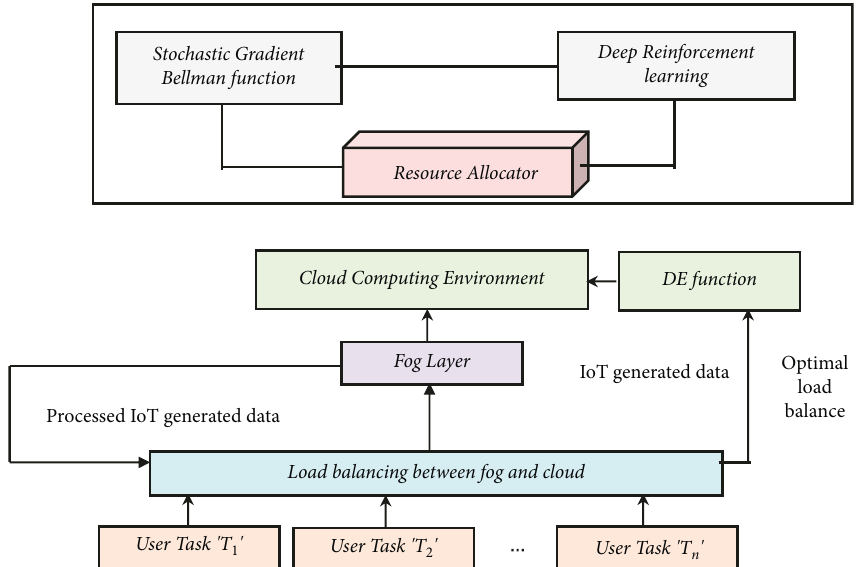
Figure 1: Block diagram of Differential Grey Wolf load balancing and Stochastic Bellman Deep Reinforced resource optimization (DGW-SBDR) method.